Question: Express in one sentence what the figure is showing.
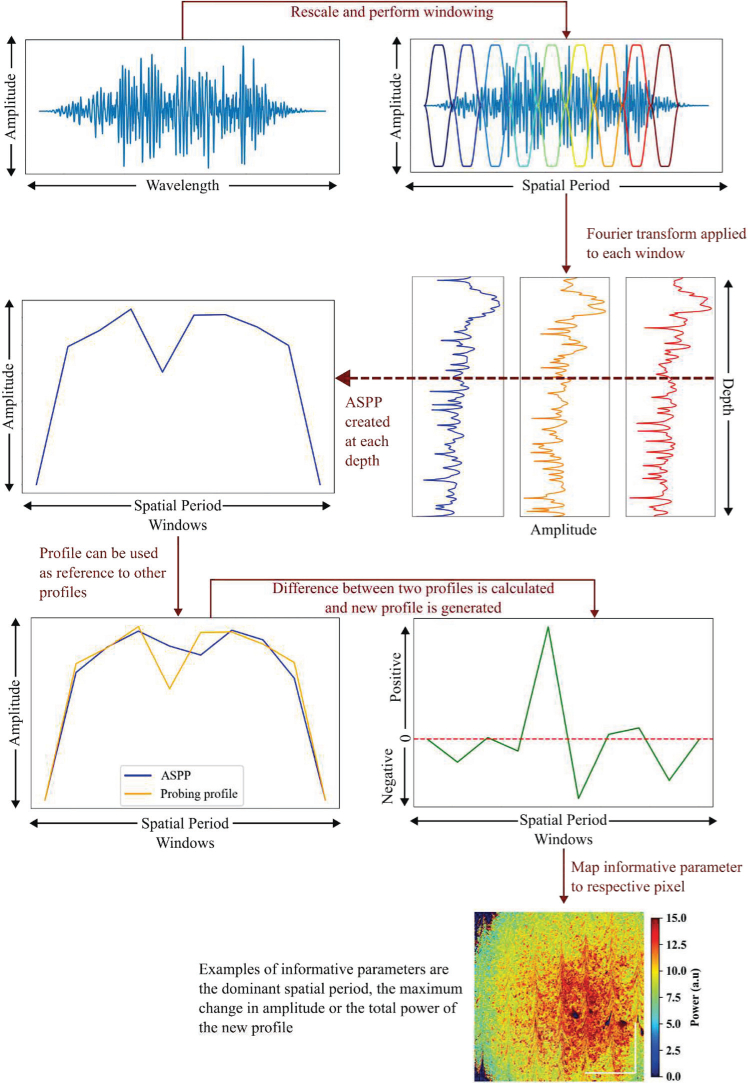
Answer: Flow chart of difference in ASFP algorithm processing.